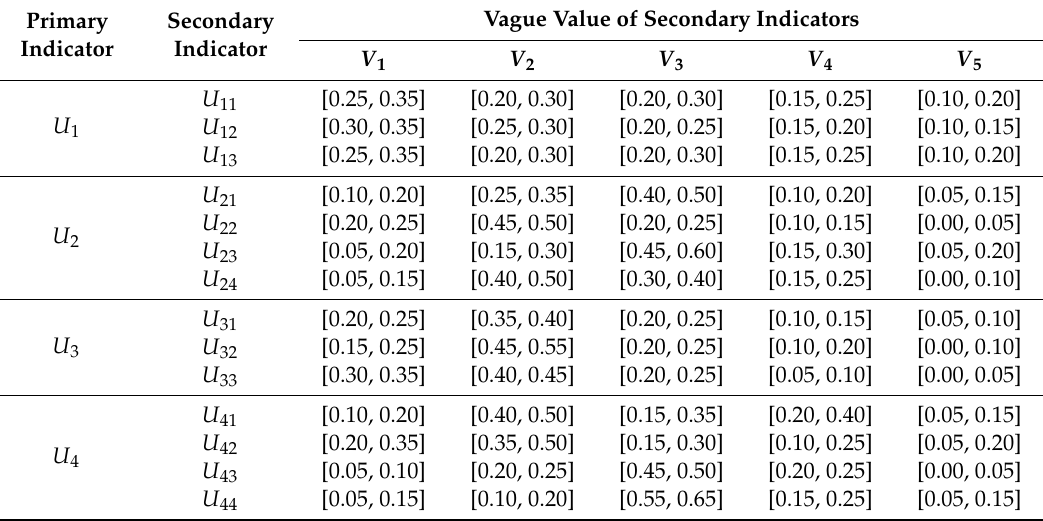
Table 7. Value of secondary indicators (Project 2).